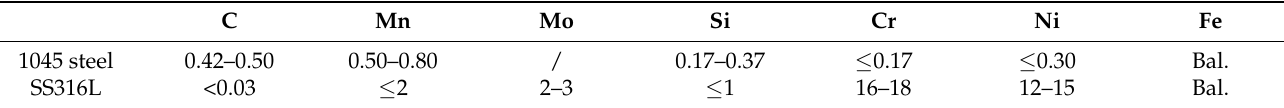
Table 1. Chemical compositions of 1045 steel substrate and SS316L powder (wt